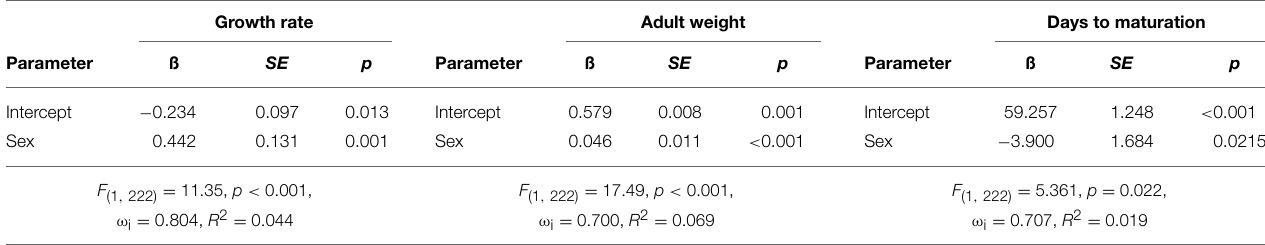
TABLE 3 | Top general linear models predicting growth rate, weight at maturation (adult weight), and the number of days until maturation.